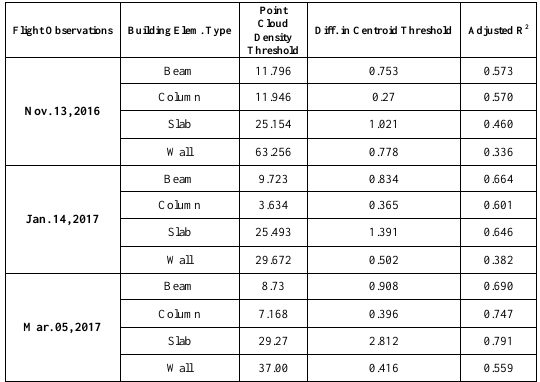
Table 3. Summary of threshold value for each type of building element